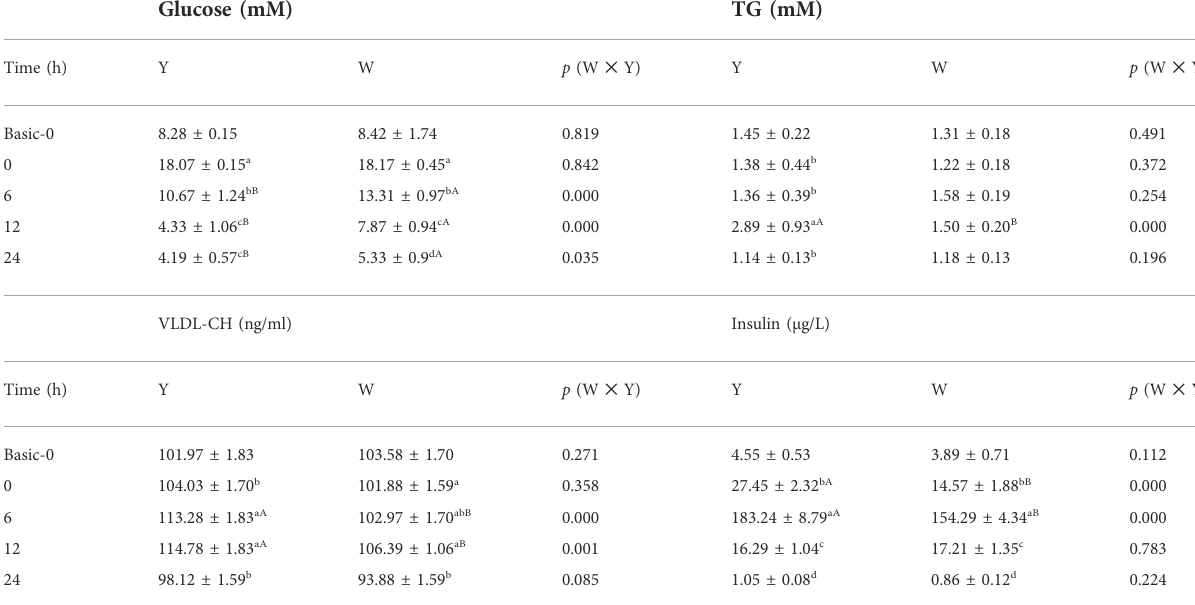
TABLE 2 Plasma parameters. Data are expressed as mean ± SD ( n = 12). Different letters indicate signi fi cant differences ( p < 0.05). Lowercase letters mean the differences in the same strain at different time points; Capital letters mean the differences between the two strains at the same time point.